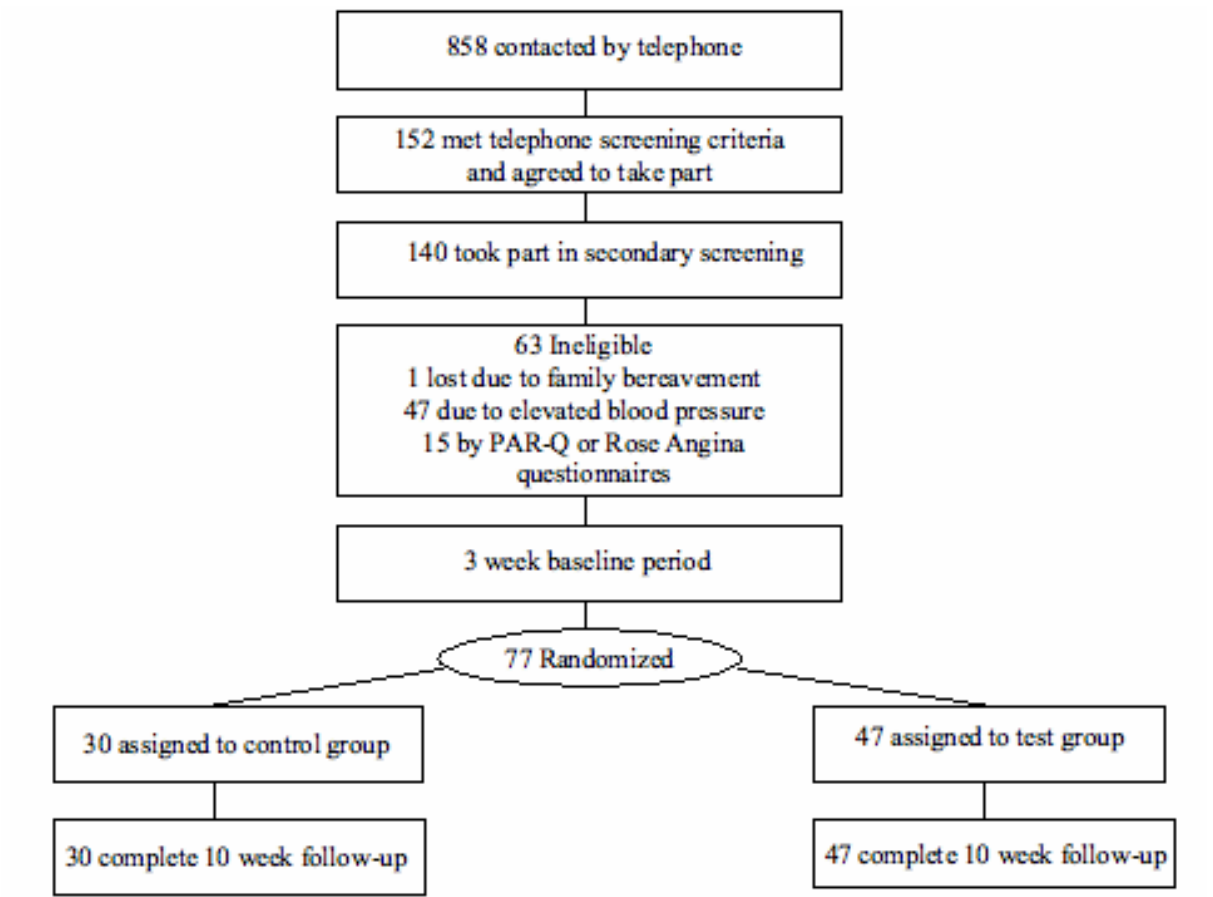
Figure 1. Flow diagram of study